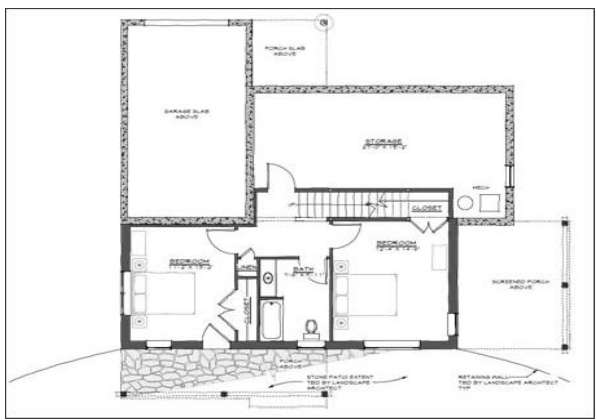
Figure 3. Comunity House, Lower Floor.